Question: Based on the figure, does the quantity rise or fall?
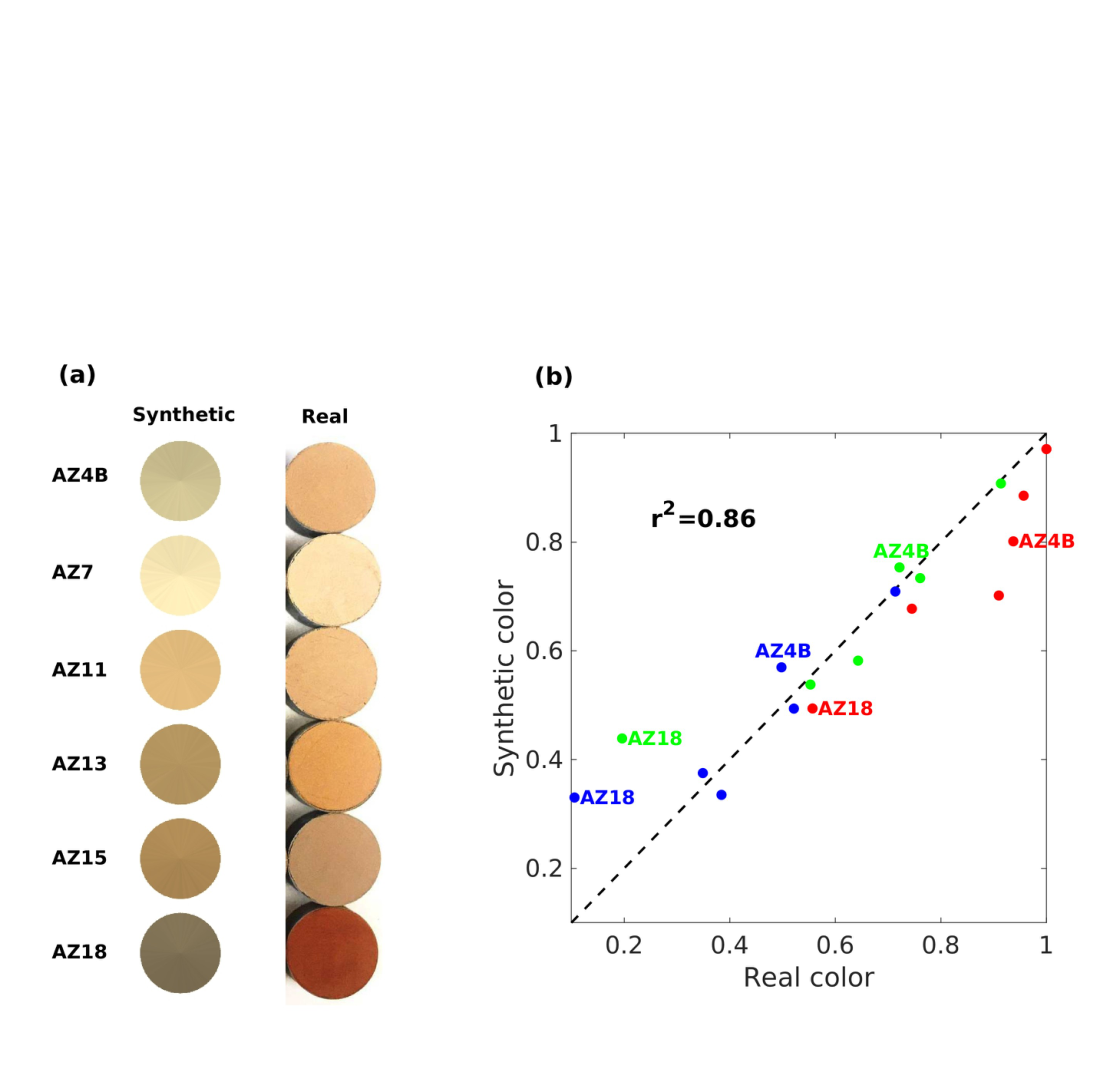
Answer: increasing